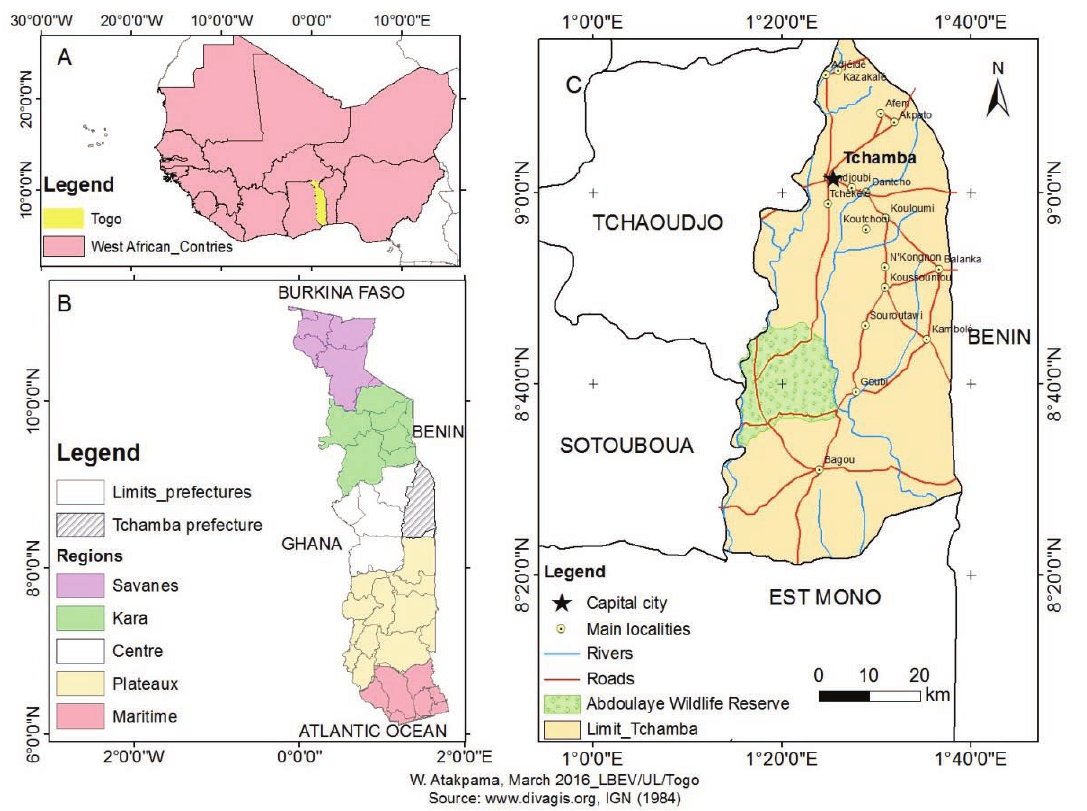
Figure 1: Map of Togo showing the study area. A : Togo in West Africa. B : Togo and its different regions and districts. C : Tchamba District with the localities prospected during the